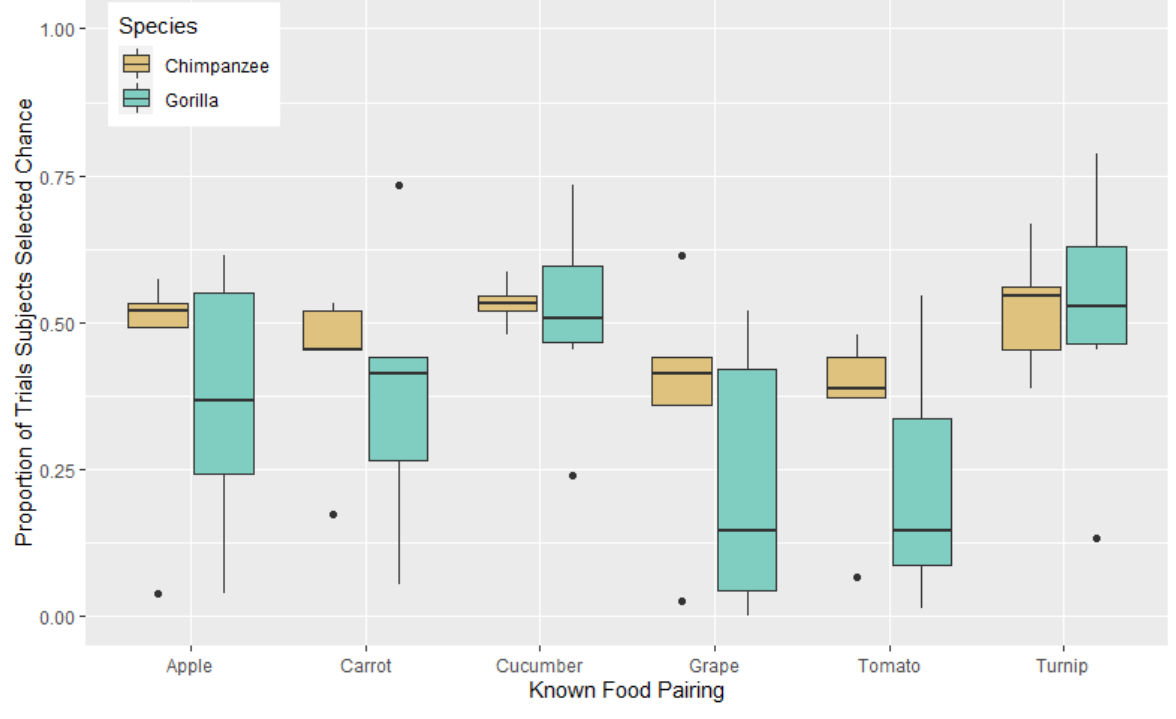
The Average Proportion of Trials in Which Chimpanzee and Gorilla Subjects Selected the Chance Symbol over the Known Food